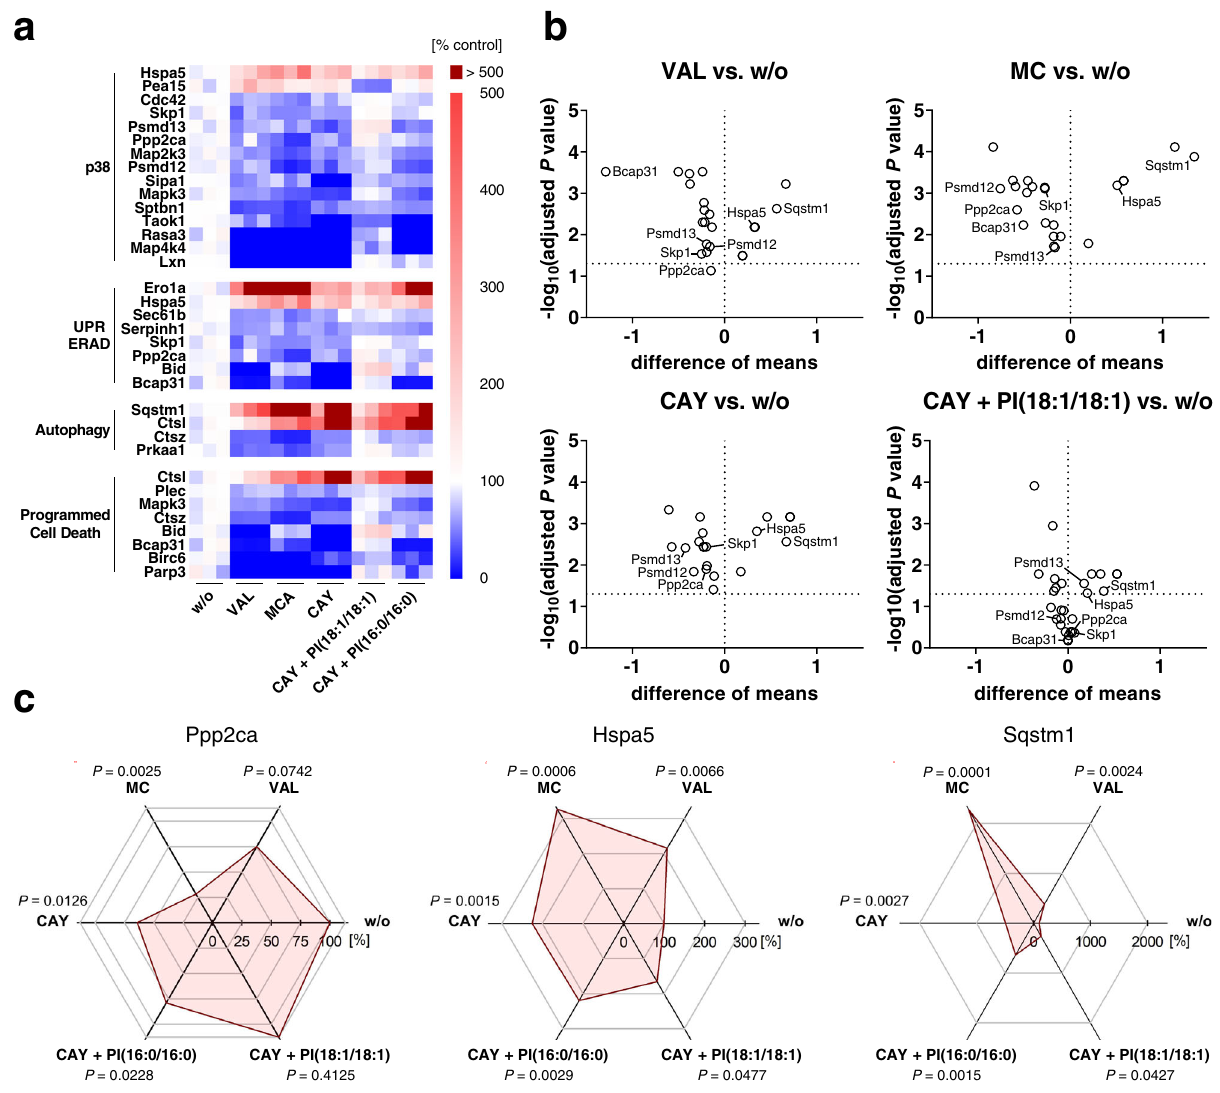
Fig. 8 Mechanistic insights into stress regulation by PI(18:1/18:1) from quantitative proteomics. Fibroblasts were treated with vehicle, VAL (10 µ M), MC (10 µ M), CAY10566 (CAY, 3 µ M), CAY (3 µ M) plus PI(18:1/18:1) (50 µ M), or CAY (3 µ M) plus PI(16:0/16:0) (50 µ M) for 48 h. a Heatmap showing relative changes in protein levels. Focus is placed on proteins that (i) participate in p38 MAPK signaling, the UPR, autophagy, or programmed cell death, (ii) are up- or downregulated by VAL, MC, and CAY10566 in the same direction ( ≥ 20%), and iii) for which co-treatment with PI(18:1/18:1) diminishes the effect ( ≥ 10%) more pronounced than PI(16:0/16:0) ( ≥ 10% difference). Data of independent experiments ( n = 3) were calculated as percentage of vehicle control. b Volcano plots highlighting proteins that are regulated by VAL, MC, CAY or by PI(18:1/18:1) supplementation in CAY-treated cells compared to vehicle control. Comparisons of the indicated treatment groups show the difference of mean absolute intensities of log 10 data and the negative log 10 (adjusted P value). c Radar charts indicating the percentage changes of cellular Ppp2ca, Hspa5, and Sqstm1 in fi broblasts treated with VAL, MC, CAY, CAY + PI(16:0/16:0), or CAY + PI(18:1/18:1) relative to vehicle control. Single data ( a ) or mean ( b , c ) from n = 3 independent experiments. Adjusted P values given vs. vehicle control; two-tailed multiple unpaired student t tests from log data with correction for multiple comparisons using a two-stage linear step-up procedure by Benjamini, Krieger, and Yekutieli (false discovery rate 5%) ( b , c ). expected from the preferential loss of p53 in IgM - as compared to immunosuppressive, and chemoresistant capacity is increased by sustained stress signaling 62 . Notably, high PI(36:2) levels have IgM + lymphomas 64 . Ulk1 participates in the initiation of been reported for tumor cell lines and pancreatic neoplasia in autophagy and is inhibited by mTORC1 through phosphorylation mice and were ascribed to p53 mutations 63 . PI(36:2) comprises at Ser757 65 . In agreement with enhanced mTORC1 activity 66 , the multiple isobaric species including PI(18:1/18:1). To substantiate phosphorylation of further target proteins (4E-BP1, S6-kinase that PI(18:1/18:1) is regulated during tumorigenesis, we investi- and its substrate rpS6, Fig. 9b) was enhanced. Together, the gated B-cell lymphoma from Eµ-Myc-transgenic mice relative to increase of PI(18:1/18:1) in B-cell lymphoma is associated with pre-tumoral IgM - B-cells and found a strong accumulation of elevated mTORC1 activity and inhibition of ULK1, indicative of PI(18:1/18:1) in lymphomas (Fig. 9a). The increase in PI(18:1/ impaired autophagy. 18:1) ratios during malignant transformation was associated with Sorafenib has been reported to kill cancer cells by inhibiting enhanced Ulk1 phosphorylation at Ser757 (Fig. 9b). The effect SCD1-mediated MUFA biosynthesis 67 . To investigate the role of was less pronounced for the IgM + phenotype (Fig. 9a), as NATURE COMMUNICATIONS| (2022) 13:2982